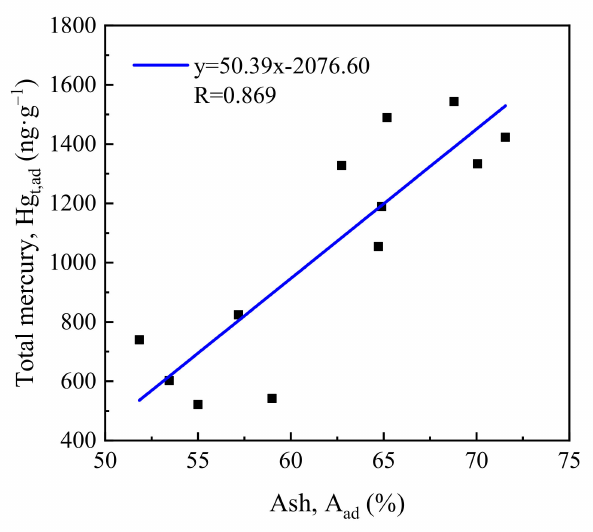
Figure 10. Correlation between Hg and ash in gangue